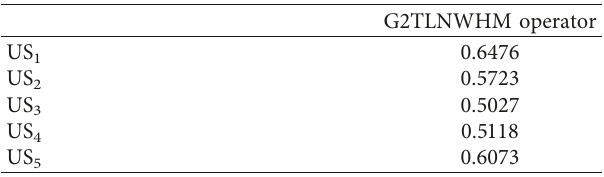
Table 3: The score values of the university students.